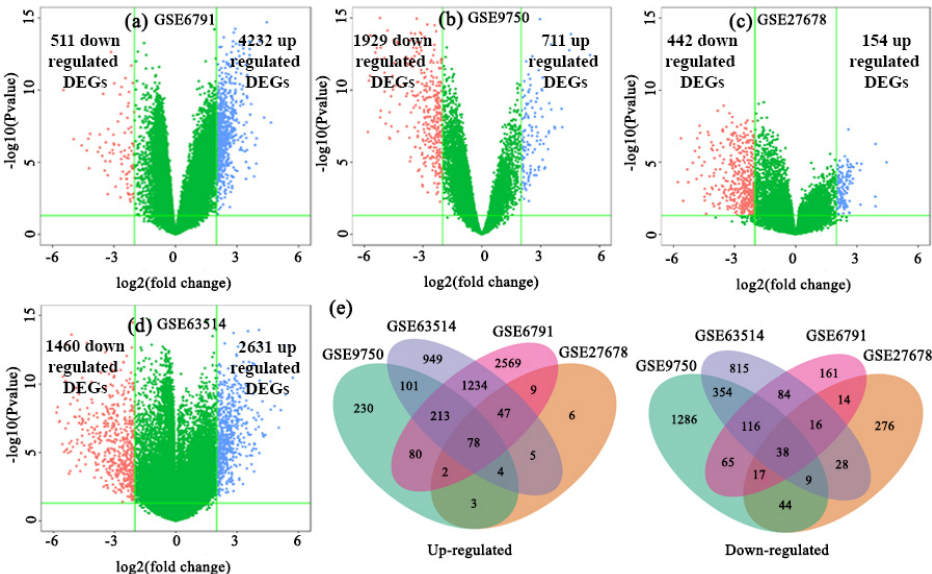
Figure 2. Screening of the overlapping DEGs among GSE6791, GSE27678, GSE63514, and GSE9750 datasets. The volcano plots of DEGs in ( a ) GSE6791, ( b ) GSE9750, ( c ) GSE27678, and ( d ) GSE63514; red dots and blue dots represented the significantly down-regulated and up-regulated DEGs, re- spectively. ( e ) Common up-regulated and down-regulated differentially expressed genes from CC visualized through a Venn diagram. Seventy-eight genes were founded common- up-regulated and thirty-eight genes were founded common down-regulated in CC